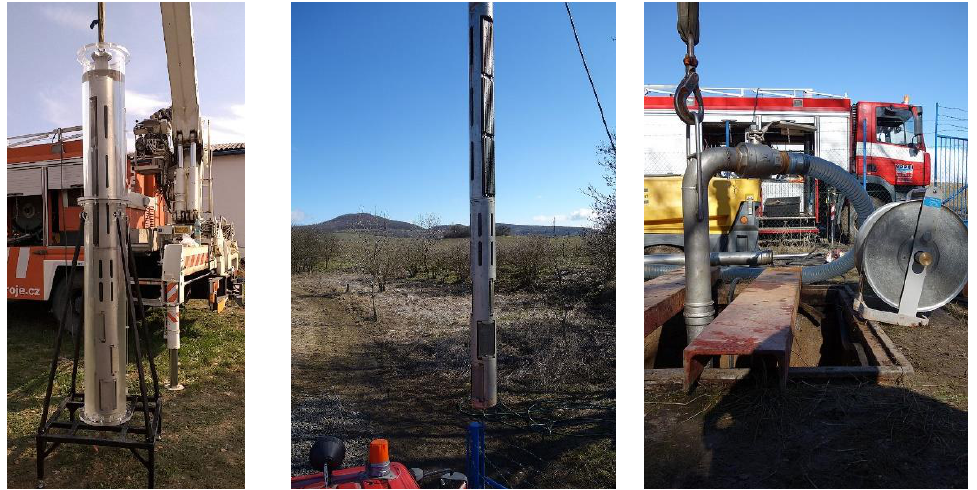
Figure 5. Ultrasonic probe in action (prototype by SONIC TECHOLOGIES, Inc.).